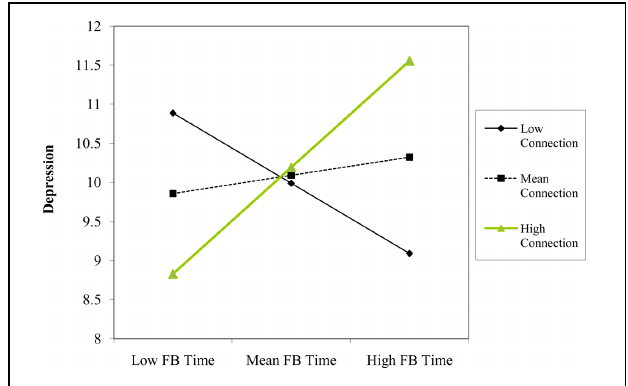
FIGURE 6 | Participant’s Facebook time and connection level as interactive predictors of scores on depression construct.